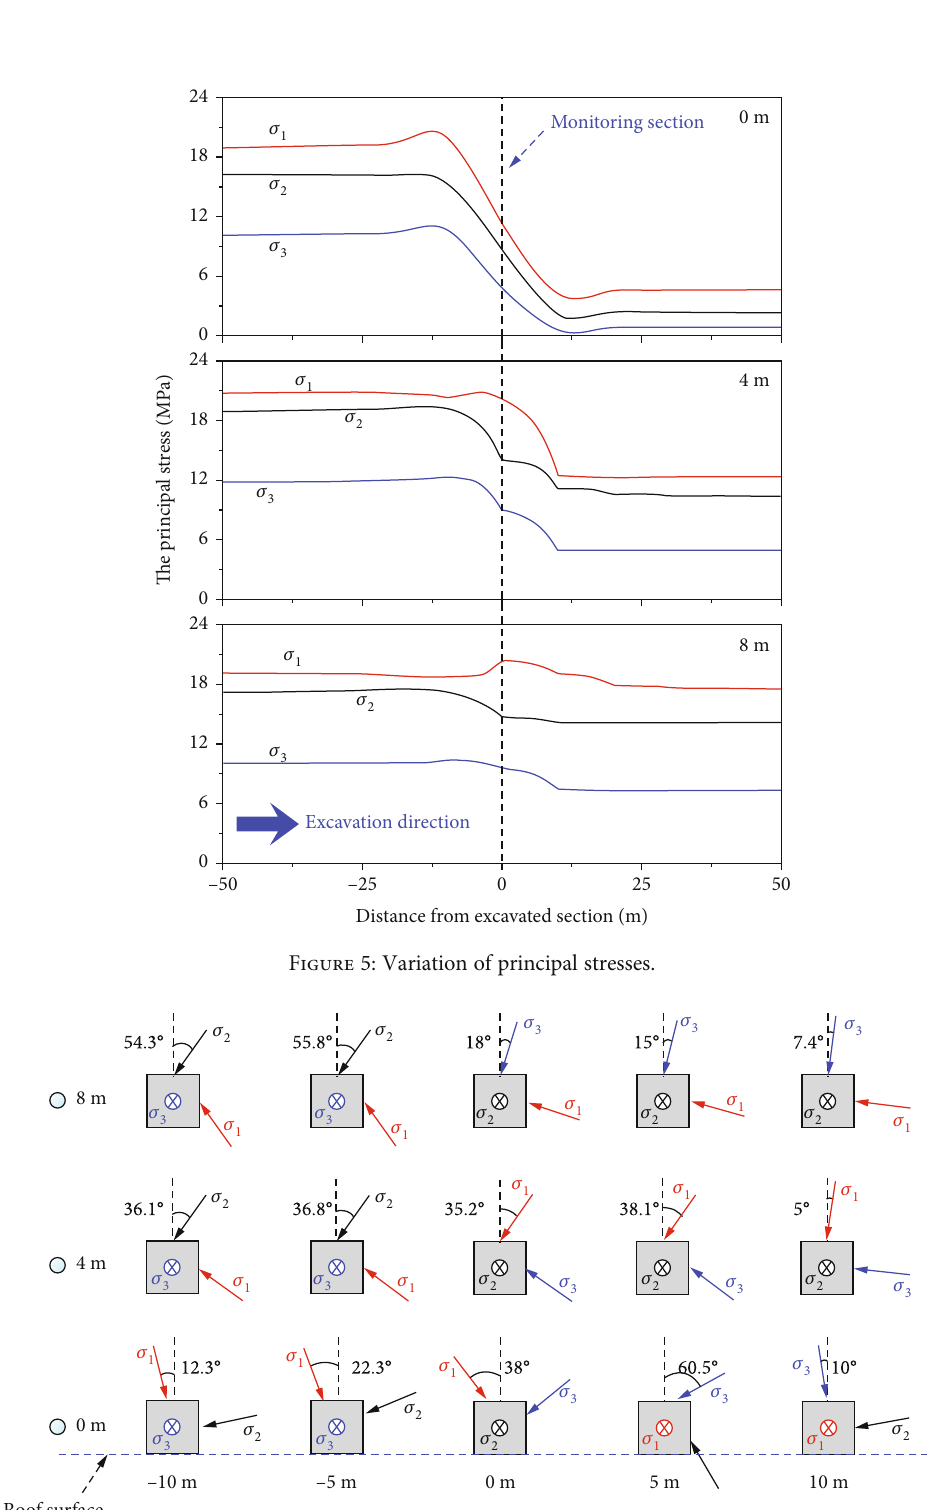
Figure 6: Variation of principal stress directions in the entry